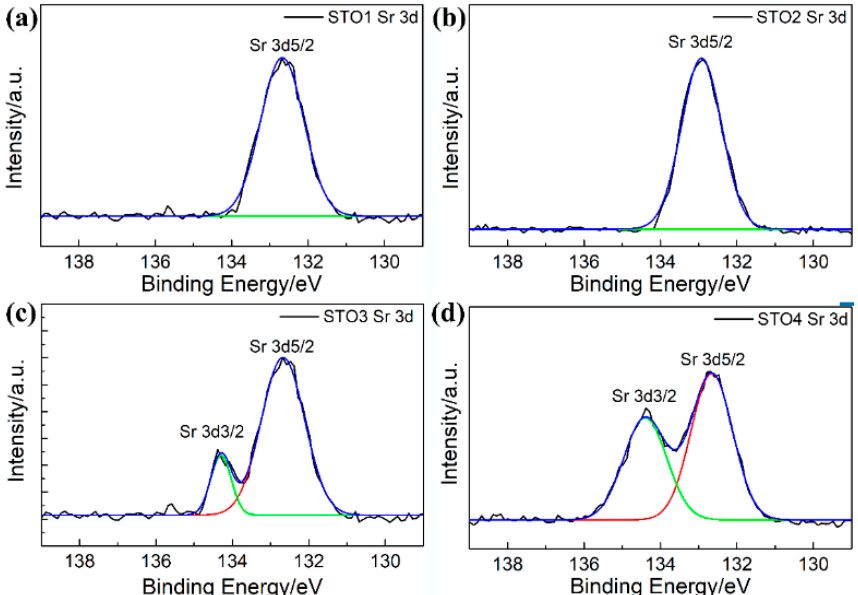
Figure 4. X-ray photoelectron spectroscopy (XPS) spectra of Sr 3d of TiO2@SrTiO3 heterostructured nanowire arrays: ( a ) STO1, ( b ) STO2, ( c ) STO3, ( d ) STO4.